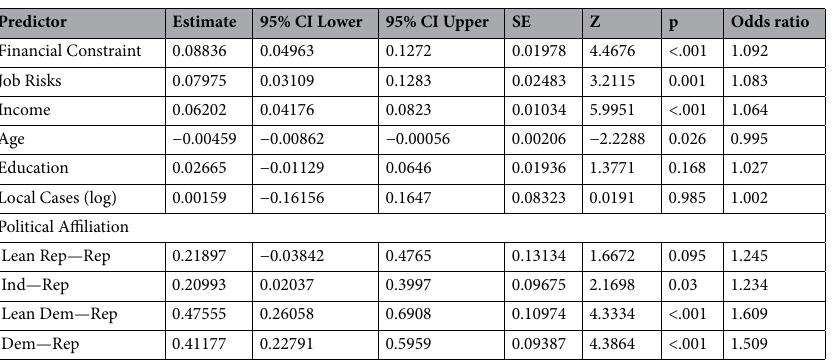
Table 2. Model coefficients for ordinal logistic regression predicting beliefs about personal